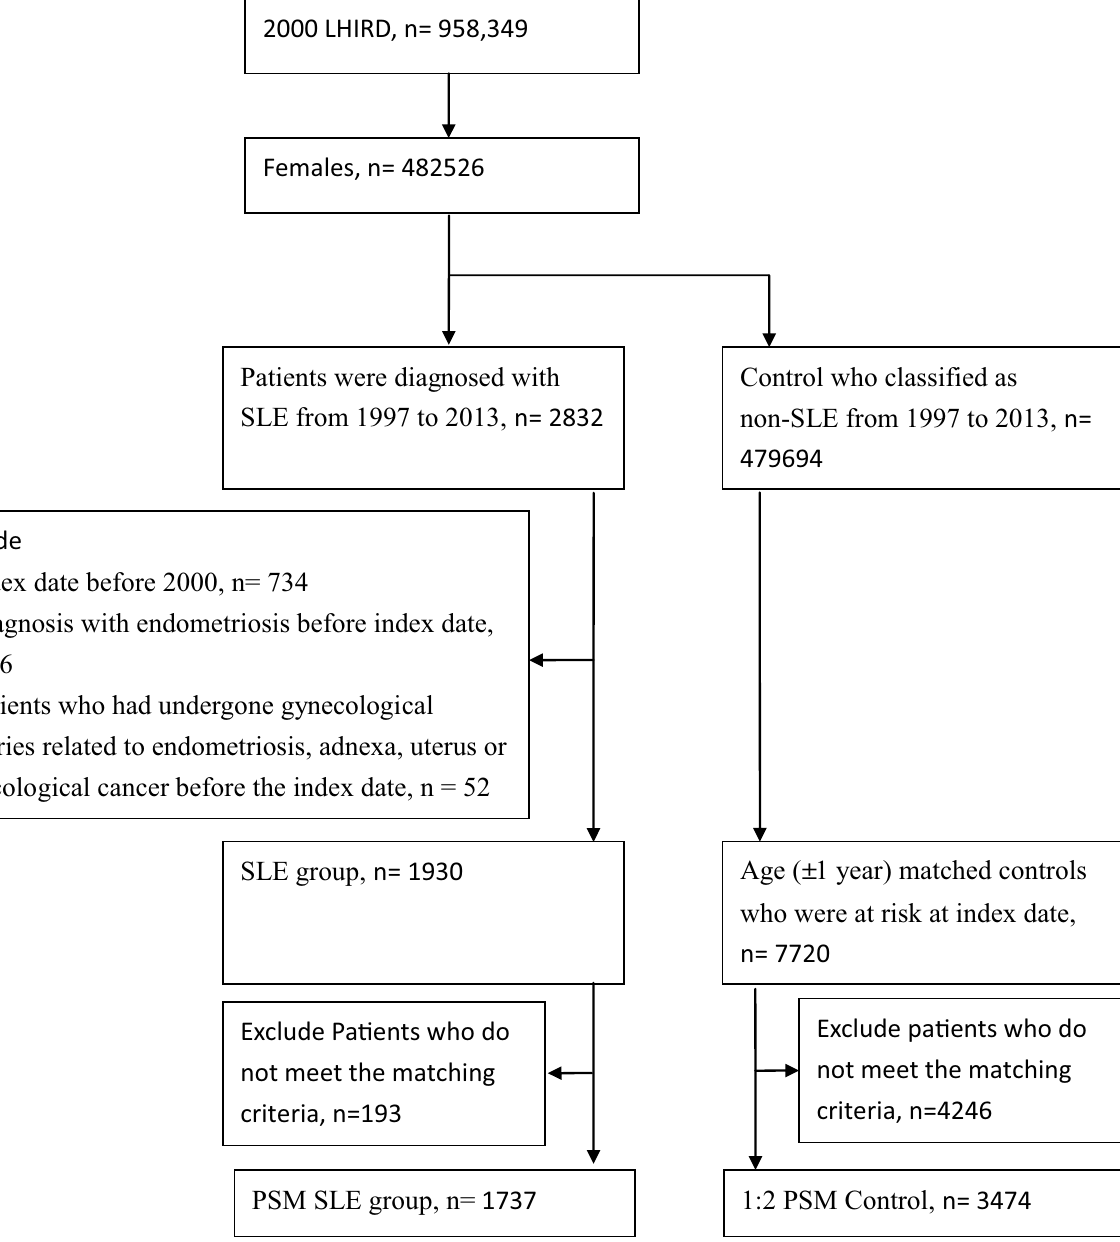
Figure 1. Flowchart of enrollment of the SLE cohort and the non-SLE cohort from the Longitudinal Health Insurance Database,